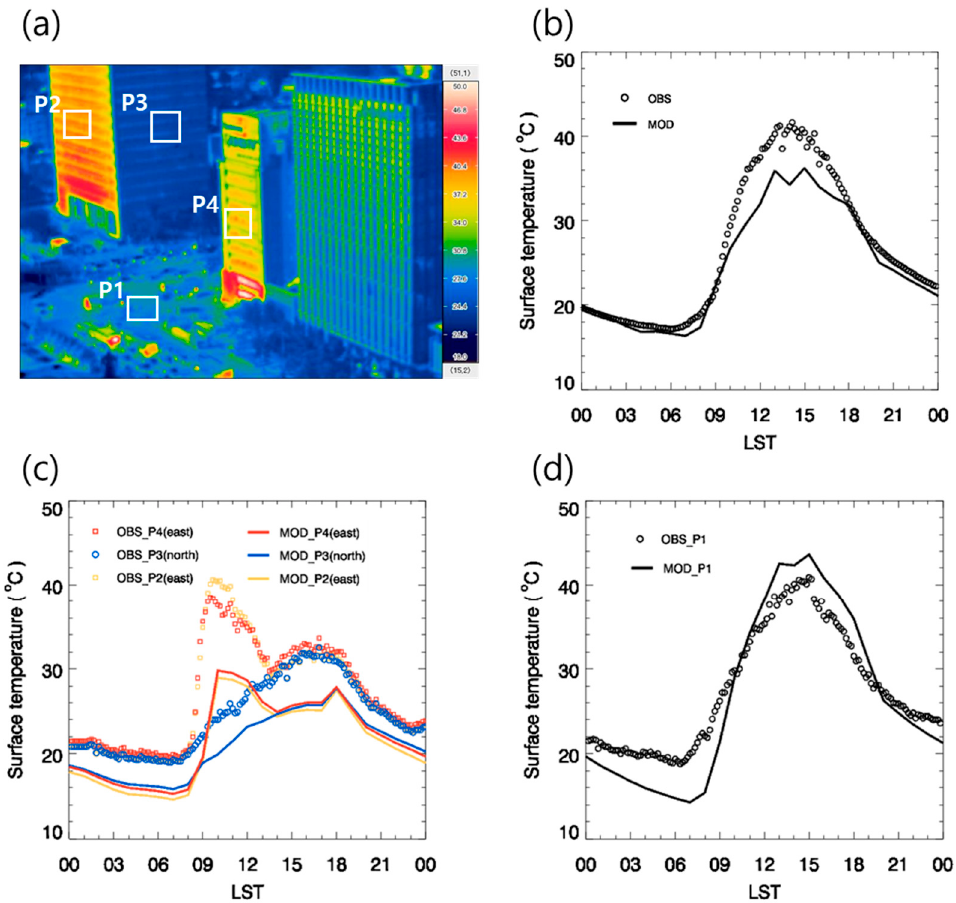
Figure 8. ( a ) The specific locations of the surface temperatures obtained from the infrared thermal imagery. P1: ground, P2 and P4: east-facing walls, P3: north-facing wall. ( b – d ) The comparison of the measured and simulated surface temperatures at the ( b ) roof, ( c ) walls, and ( d ) ground surfaces.